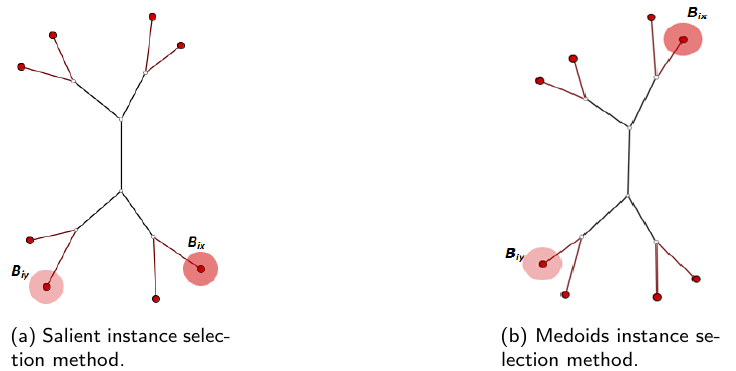
Figure 4. Methods for selecting instance prototypes B ix and B iy . Both ( a ) and ( b ) project the same instances from a positive bag B + of the MUSK1 dataset on the MILTree’s instance space i